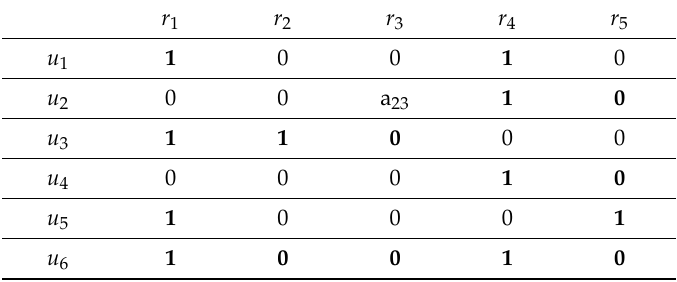
Table 15. Assignments in step 4.